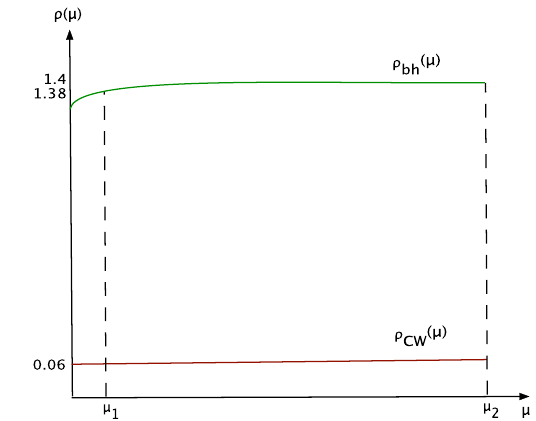
Fig. 3 The running of the ρ -parameter with respect to the energy scale μ for the boundary-hybrid model (green line) and the Coleman– Weinbergmodel(redline).As μ increases, ρ bh (μ) increasesandreaches the Standard Model value at μ 1 . At that scale it is approximately 23 times bigger than ρ CW (μ 1 ) = 0 . 06